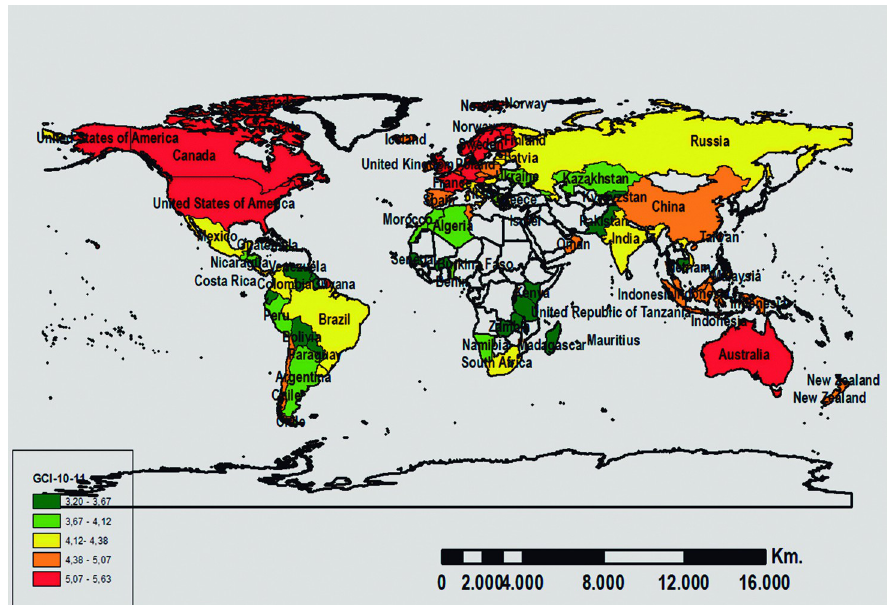
Fig 4. Geographic distribution of the WEF-GCI scores for 2010–11. Source: Prepared by authors using ArcGIS software.